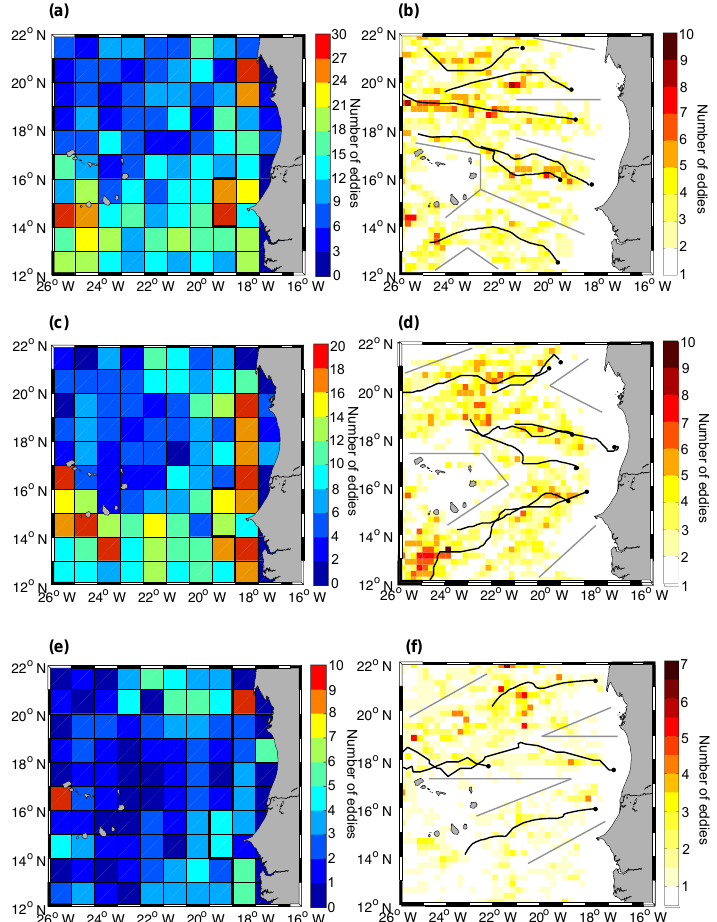
Figure 8. Number of eddies generated in 1 ◦ × 1 ◦ boxes (a, c, e) and number of long-lived eddies detected in 1 / 6 ◦ × 1 / 6 ◦ boxes based on the results of the OW method (b, d, f) for cyclones (a, b) , anticyclones (c, d) , and ACMEs (e, f) . In (b) , (d) , and (f) only eddies with a lifetime larger than 35 days are counted. In (b) , (d) , and (f) main eddy propagation corridors are indicated by straight gray lines; black lines show trajectories of long-lived eddies with a lifetime larger than 150 days. The thick solid black line along 18 ◦ W/19 ◦ W in (a) , (c) , and (e) separates the coastal region from the offshore